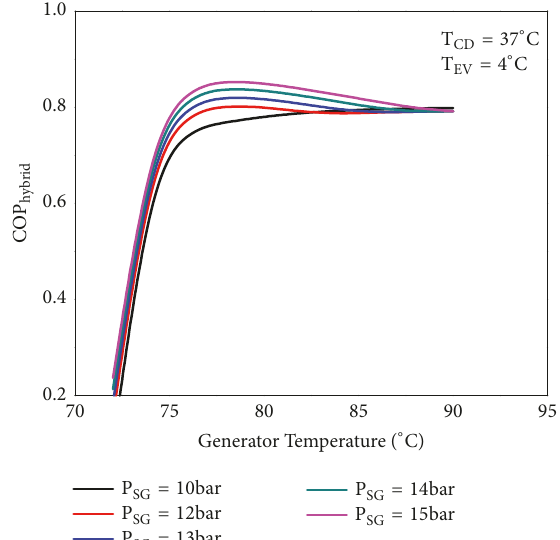
Figure 9: 𝐶𝑂𝑃 ℎ𝑦𝑏𝑟𝑖𝑑 vs . 𝑇 𝐺 for various steam-generator tempera- tures, 𝑇 𝑆𝐺 .